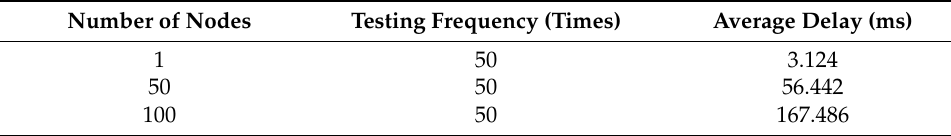
Table 9. Improved average signal delay under the LEACH protocol.